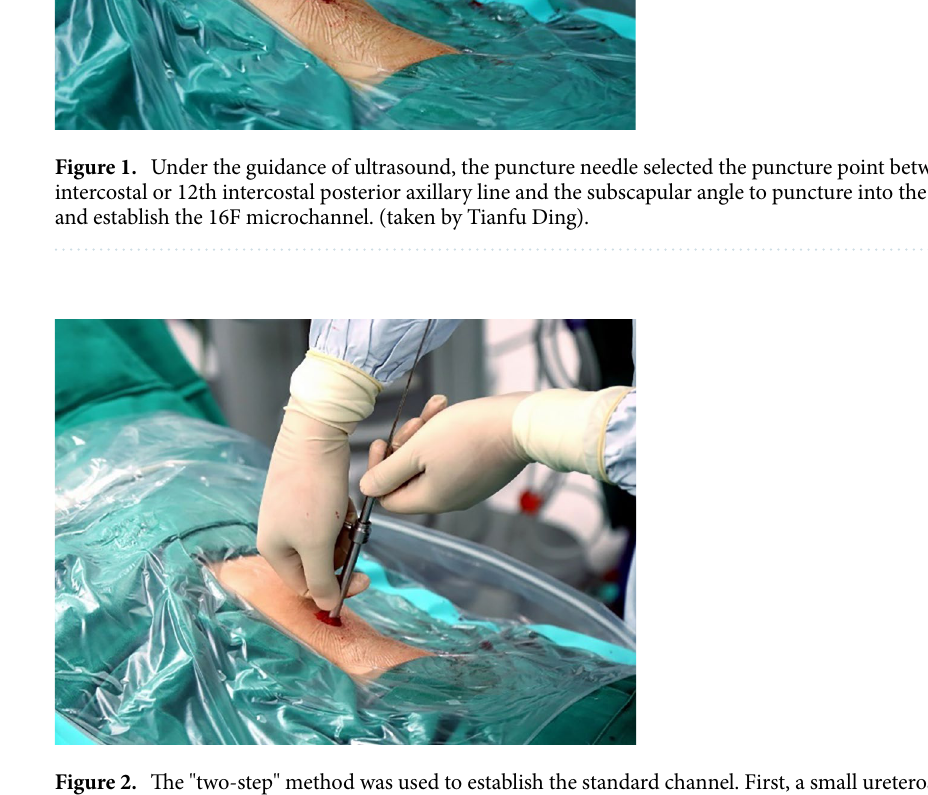
Figure 2. The "two-step" method was used to establish the standard channel. First, a small ureteroscope was used to enter the microchannel to observe the position of the channel, and the preliminary adjustment was made. After the adjustment, the sheath was gradually expanded to establish the 24F standard channel. (taken by Tianfu